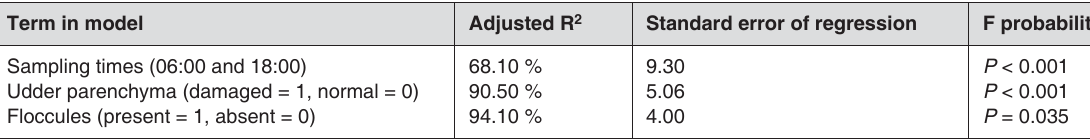
TABLE 2 Clinical mastitis in goats: Regression model Term in model